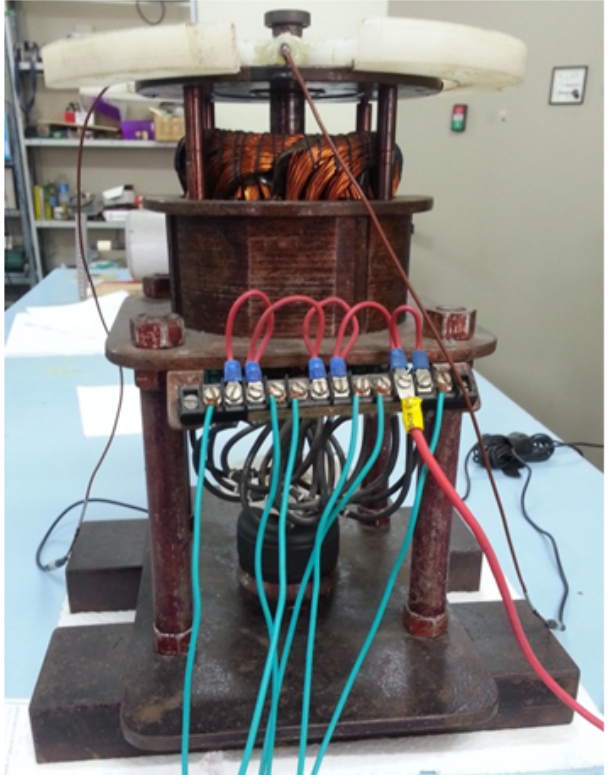
Figure 9. Image of the prototype of the bearing motor.